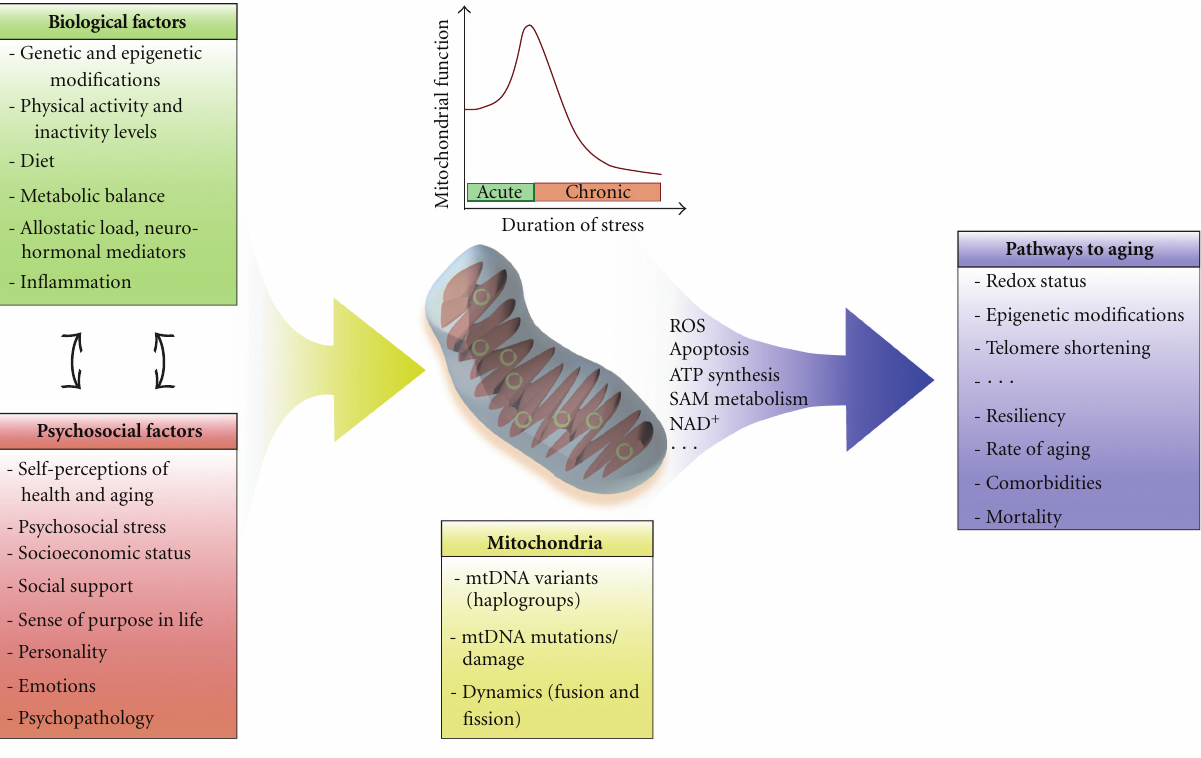
Figure 1: Mitochondria influence pathways to aging by operating at the intersection of biological and psychosocial factors. Biological and psychosocial factors dynamically/bidirectionally interact to influence mitochondrial content and function in the body’s tissues. The same factors can exert opposite e ff ects on mitochondrial function, depending on the duration of exposure. For instance, acute stressors tend to upregulate mitochondrial biogenesis and function, whereas chronic stressors tend to downregulate mitochondrial biogenesis and function (top center graph). Mitochondrial-level factors influence mitochondrial function and may determine mitochondrial responsivity to upstream biological and psychosocial influences. In response to multiple individual and environmental factors, mitochondria produce outputs influencing cellular function, gene expression, and cellular senescence. As a result, pathways to aging are ultimately determined by the integrated and synergistic influence of multiple biological and psychosocial factors.